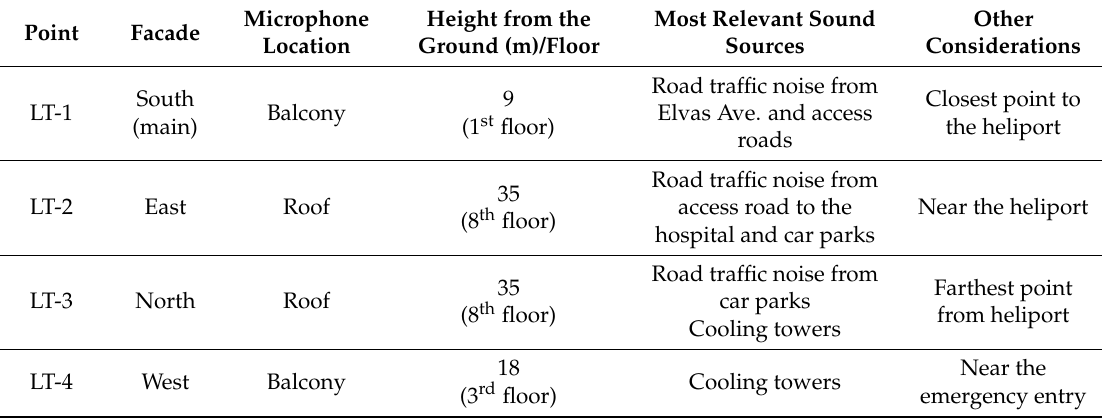
Figure 2. Location of short-term (ST-1 to ST-12) and long-term (LT-1 to LT-4) measuring points (Google Maps). Table 1. Description of long-term (LT) measuring points.